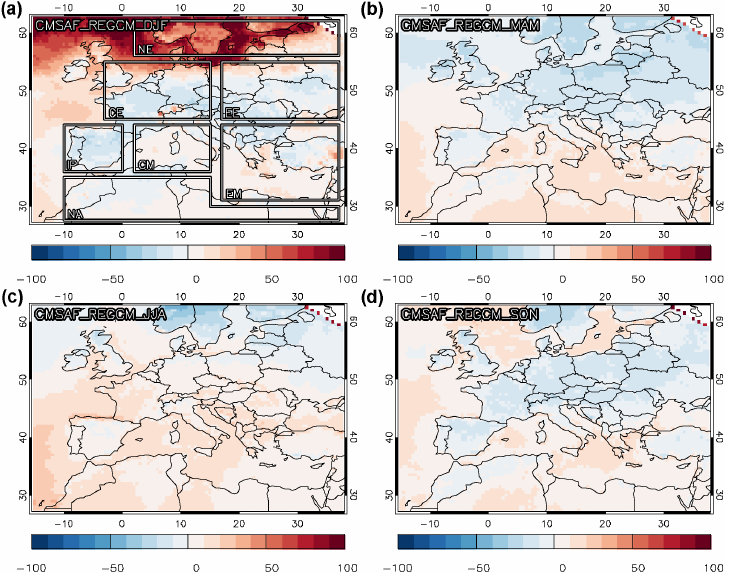
Figure 1. Seasonal NMB patterns of RegCM4–CM SAF SSR over Europe for (a) winter (DJF), (b) spring (MAM), (c) summer (JJA) and (d) autumn (SON) from MSG SEVIRI observations. The seven sub-regions used for the generalization of the results are marked in (a) : northern Europe (NE), central Europe (CE), eastern Europe (EE), Iberian Peninsula (IP), central Mediterranean (CM), eastern Mediterranean (EM) and northern Africa